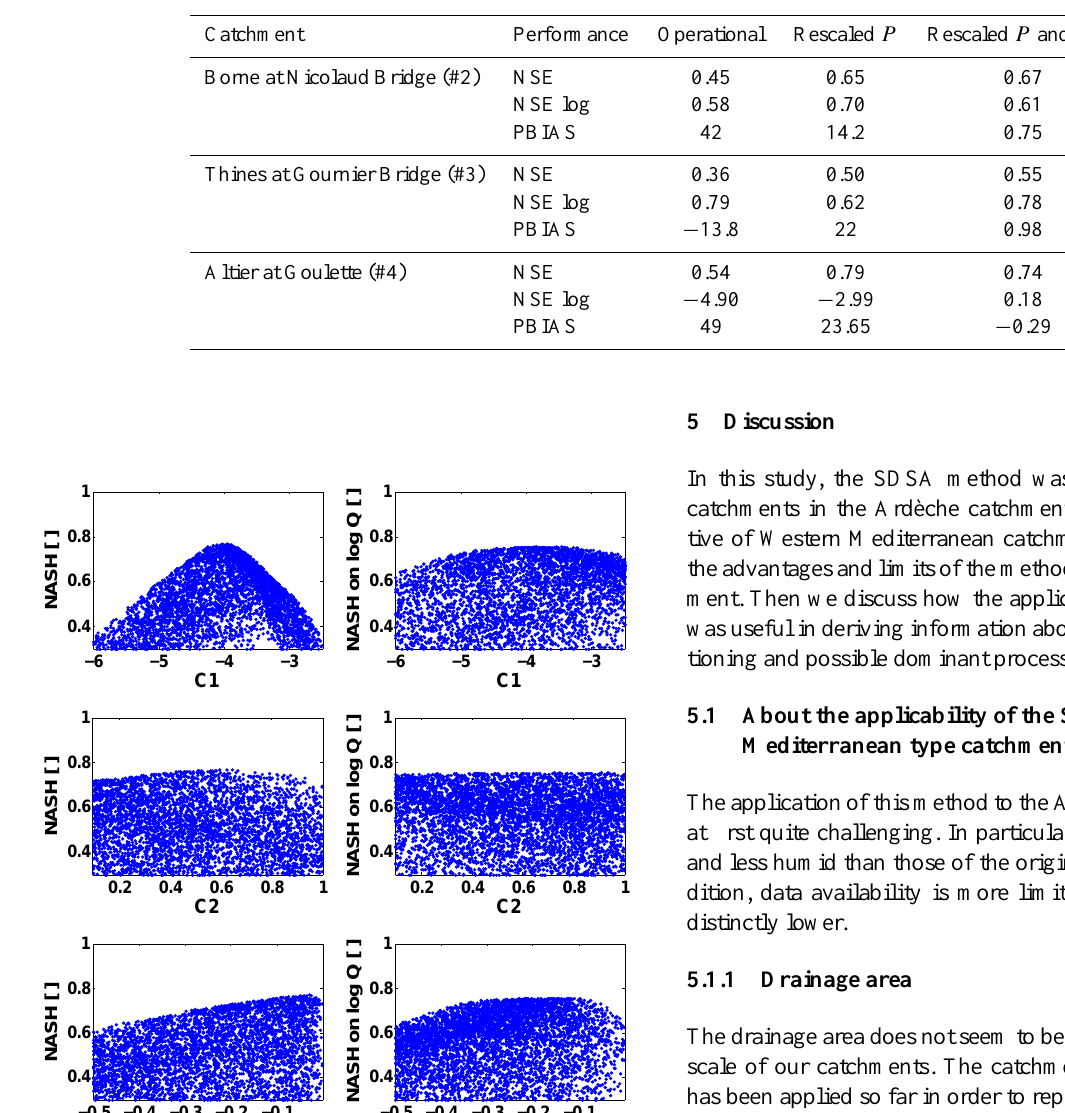
Table 11. Model performance for three examined catchments over the whole examined period (2000–2008), comparing the original opera- tional data and rescaled precipitation and evapotranspiration data.